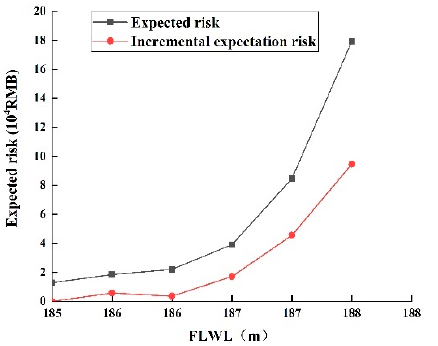
Figure 4. Expected risk and expected risk increases at different water levels.